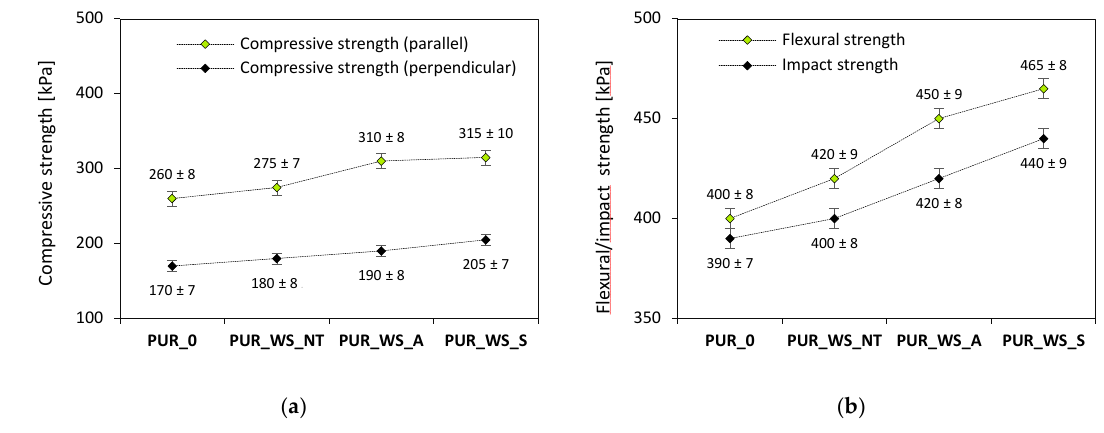
Figure 7. ( a ) Compressive, ( b ) flexural and impact strength of PUR foams.